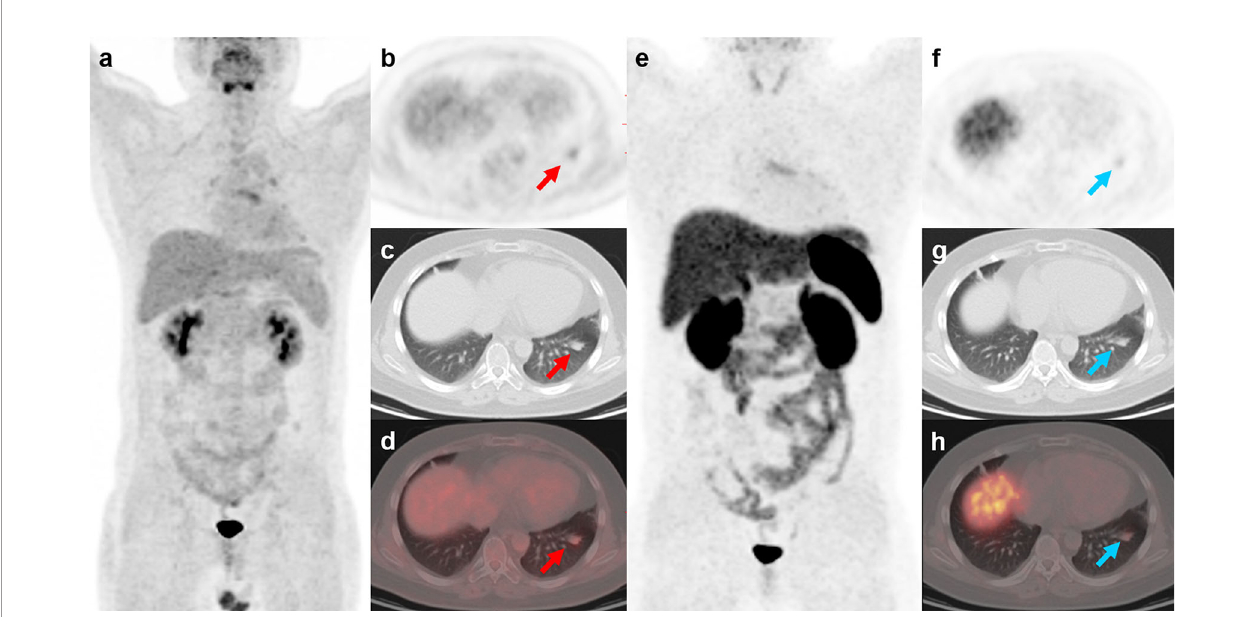
FIGURE 5 | 18 F-FDG and 68 Ga-DOTATATE PET/CT fi ndings in a representative case of typical carcinoid (Patient, 10). A 24-year-old man with ectopic Cushing syndrome underwent 18 F-FDG and 68 Ga-DOTATATE PET/CT for detecting the source tumor of ACTH secretion. 18 F-FDG PET/CT showed a nodule with mild activity ( A – D ; red arrows; SUVmax, 2.7) in the left lung. 68 Ga-DOTATATE PET/CT also demonstrated slightly increased uptake in the nodule ( E – H ; blue arrows; SUVmax, 2.0), indicating somatostatin receptor expression. The nodule was then surgically removed and postoperative histopathology con fi rmed typical carcinoid with ACTH positivity in immunohistochemistry.